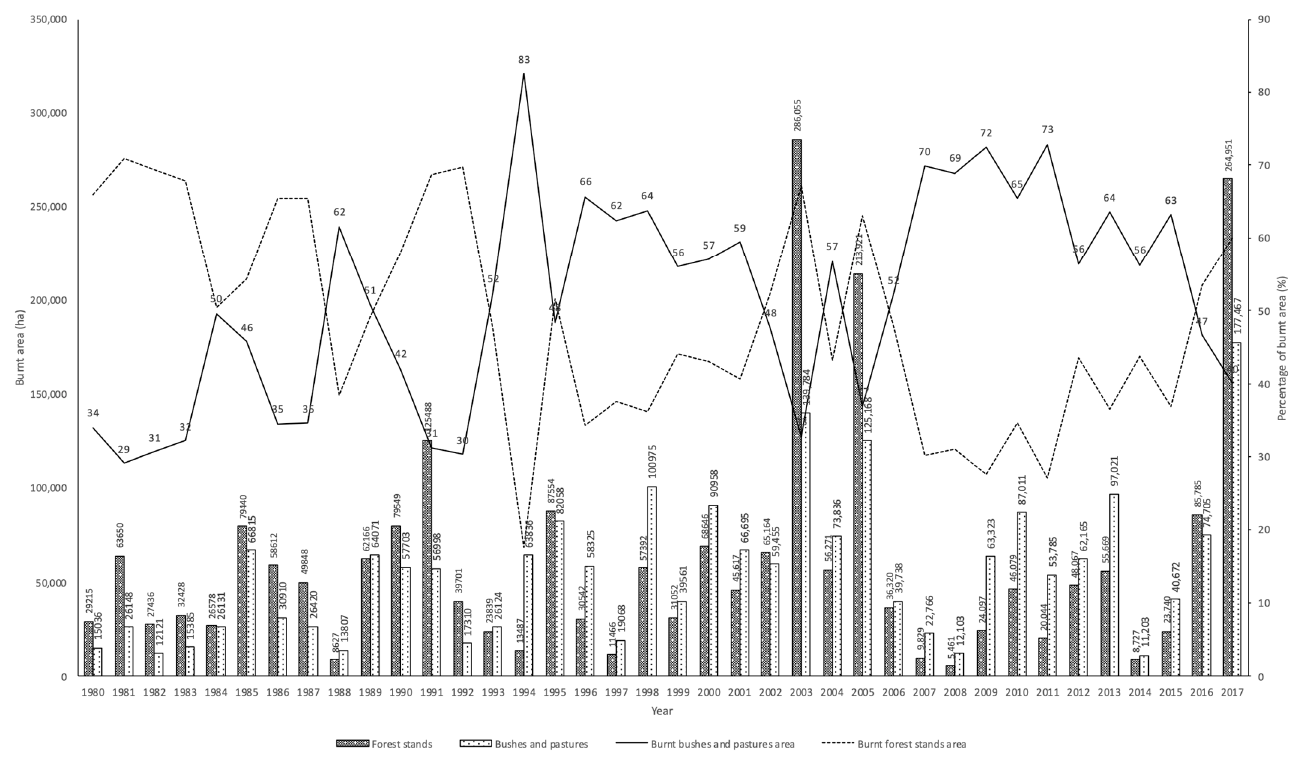
Figure 15. Comparison between burnt areas occupied by forest and by scrub and pasture.